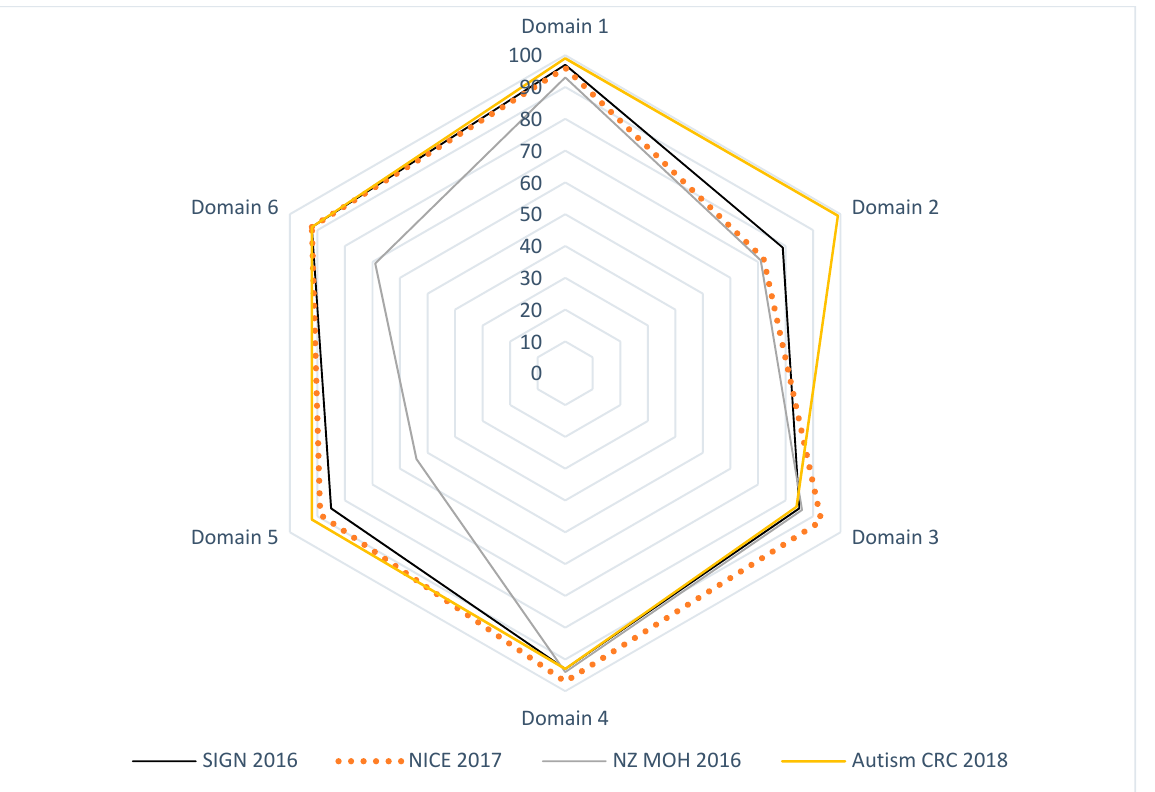
Figure 1. Radar map of the AGREE II final standardized domain scores for eligible appraised ASD CPGs.